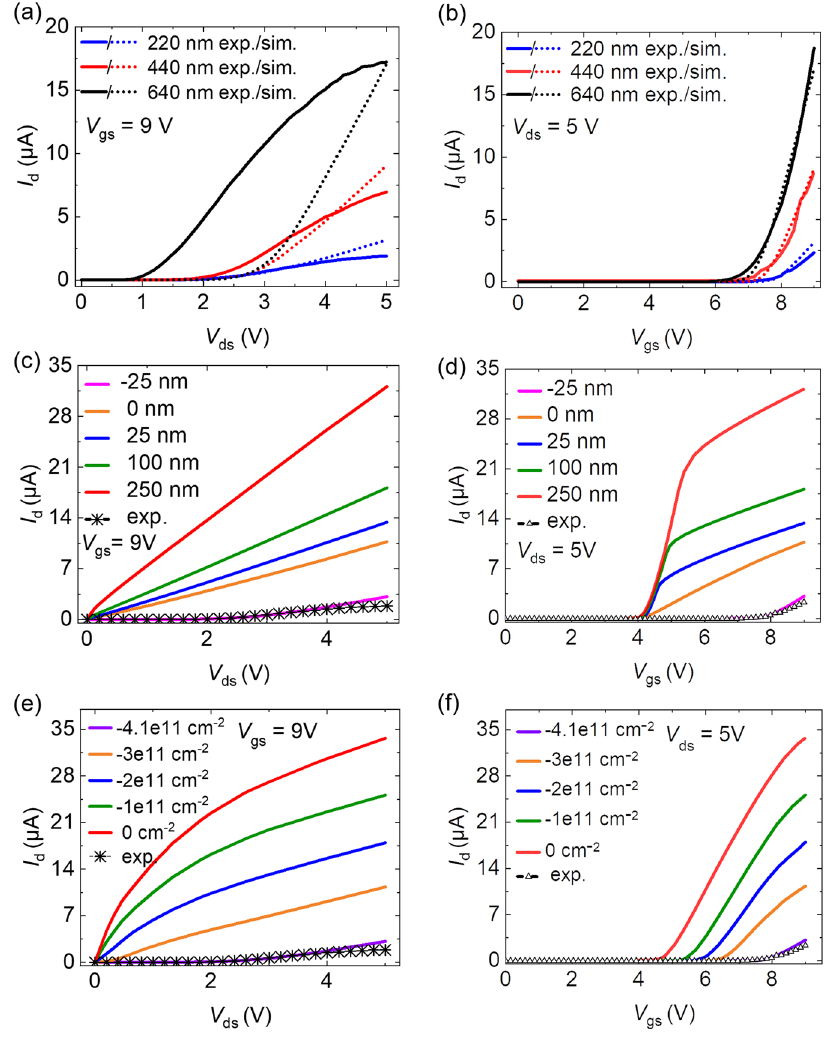
Figure 6. Experimental (exp.) and simulation (sim.) results showing ( a ) output and ( b ) transfer characteristics for single NW FETs of different diameters. ( c ) Simulated output and ( d ) transfer characteristics of different L ext on single NW FETs with diameter of 220 nm and surface charge Q sc = − (3.9 ± 0.2) × 10 11 cm − 2 . The exp. data are used for comparison, which fit well with simulated results of FET with L ext of − 25nm. ( e ) Simulated output and ( f ) transfer characteristics of different Q sc on NW sidewall in case of single NW FETs with diameter of 220 nm and L ext = − (21 ± 4)